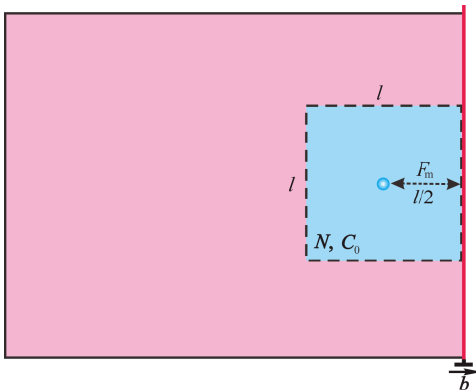
Figure 6. Schematic diagram of the interaction between the dislocation and the Cottrell atmosphere.